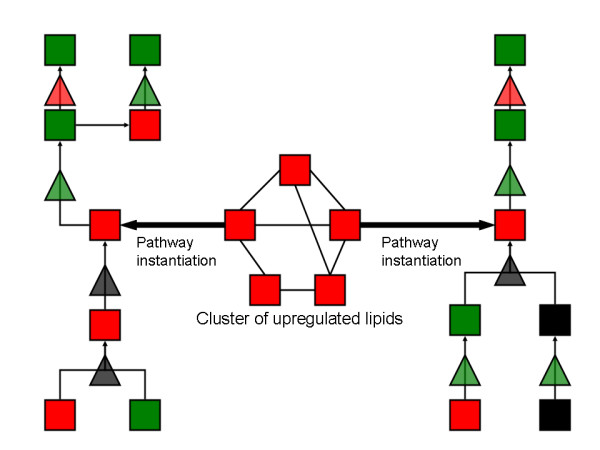
Lipid pathway instantiation. An illustrative example of instantiation of two co-regulated molecular species in the context of known lipid pathways. Upregulated species and enzymes (triangles) are in red, downregulated in green, unchanged in black.